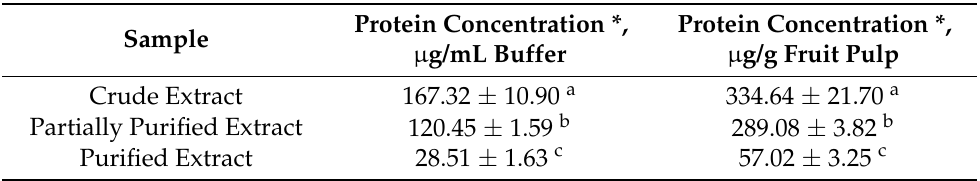
Table 1. Protein content ( µ g/g fruit pulp) of the crude, partially purified and purified extracts as calculated using colorimetric Bradford assay.